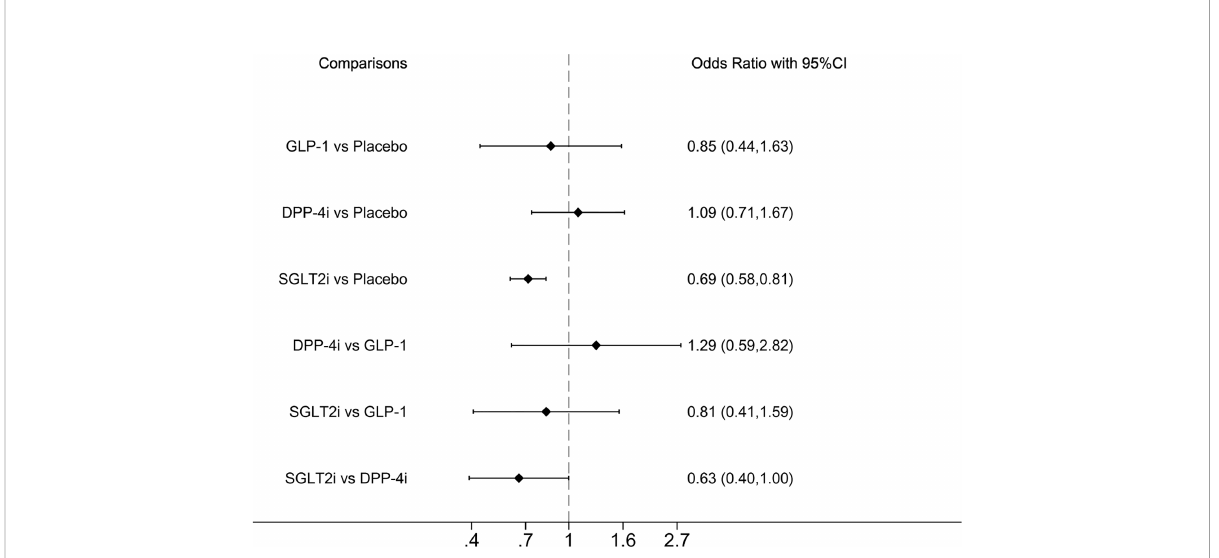
FIGURE 1 Forest plot of odds ratio comparing the serious renal-related adverse events or renal death between each medicine class or between each medicine class and